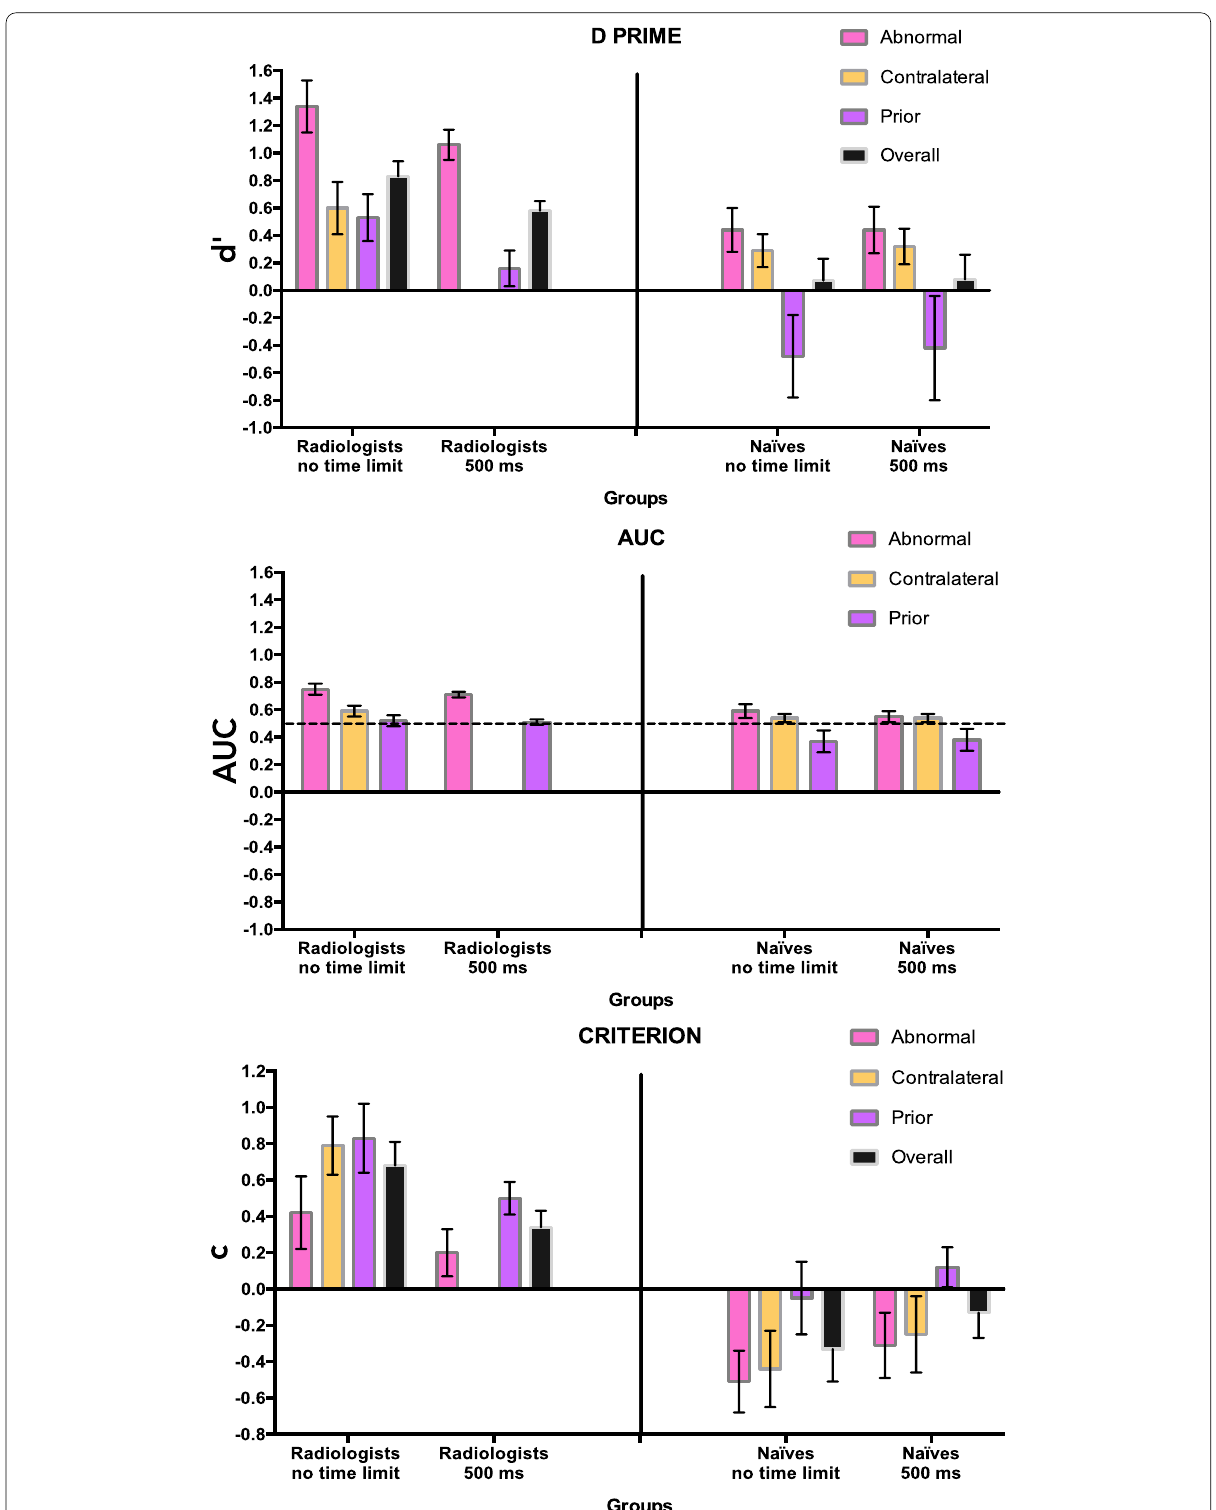
Fig. 4 Bar graphs representing the average d ′ , AUC, and criterion ( and over the total image set for the radiologists and naïves under no time limit and 500-ms time limit